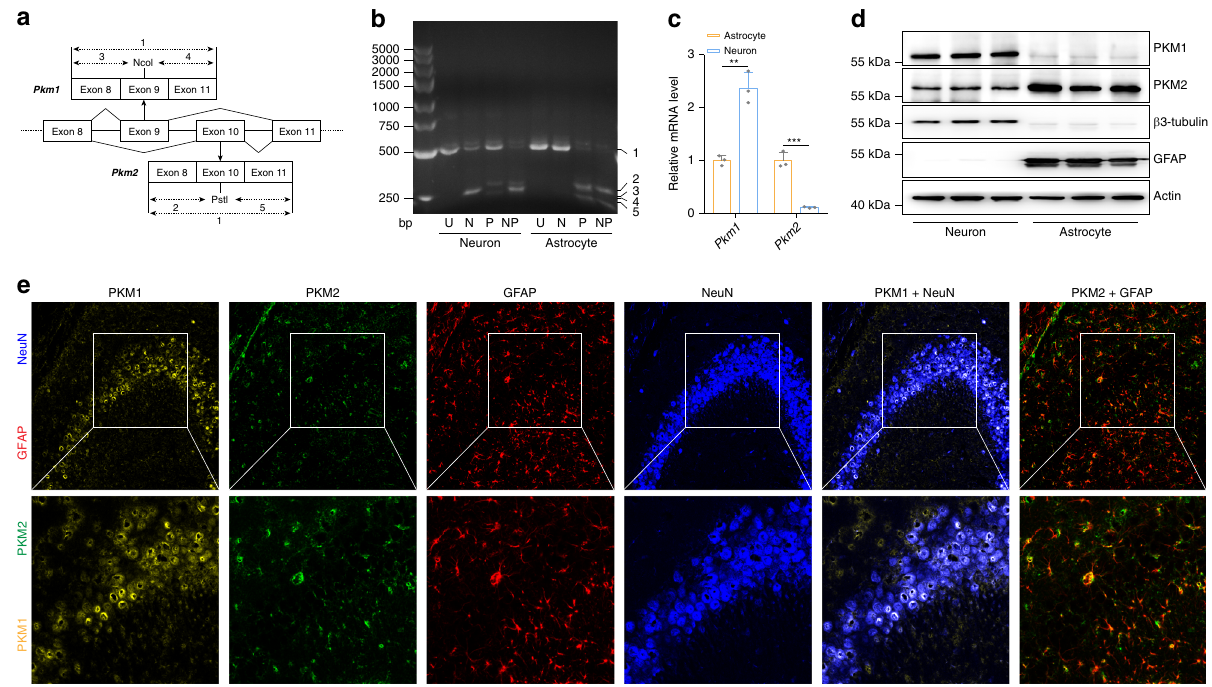
Fig. 4 Divergent expression patterns of PKM in neurons and astrocytes. a Primers annealing to exons 8 and 11 were used to amplify PKM transcripts. The PCR products were cleaved with Ncol, Pstl or both to distinguish between the PKM1 (including exon 9) and PKM2 (including exon 10) isoforms. b RNA from primary neurons and astrocytes was analyzed by qRT-PCR, followed by digestion with Ncol (N), Pstl (P), or both enzymes (NP), plus an uncut control (U). The numbered bands are as follows: 1: uncut M1 or M2 (502 bp); 2: Pstl-cleaved M2 5 ’ fragment (286 bp); 3: Ncol-cleaved M1 5 ’ fragment (245 bp); 4: Ncol-cleaved M1 3 ’ fragment (240 bp); and 5: Pstl-cleaved M2 3 ’ fragment (216 bp). c Pkm1 and Pkm2 mRNA detected by qRT-PCR in primary neurons and astrocytes. d Immunoblotting with actin as a loading control. e PKM1 and PKM2 immunohistochemical signals in cortical neurons and astrocytes after tyramide signal ampli fi cation. Immunoblotting and qRT-PCR: three independent experiments. Scale bar, 50 µ m. Data are presented as the mean ± s.e.m. *** P < 0.001. Student ’ s two-tailed unpaired t -test ( c ). Source data are provided as a Source Data fi Fig. 8h, i) but did not alter the latency time in the rotarod test (Supplementary Fig. 8j) or the activity of mice in the open fi eld test (Supplementary Fig. 8k), indicating that pyridoxine can improve some types of mouse locomotion in a DRD2-independent manner.